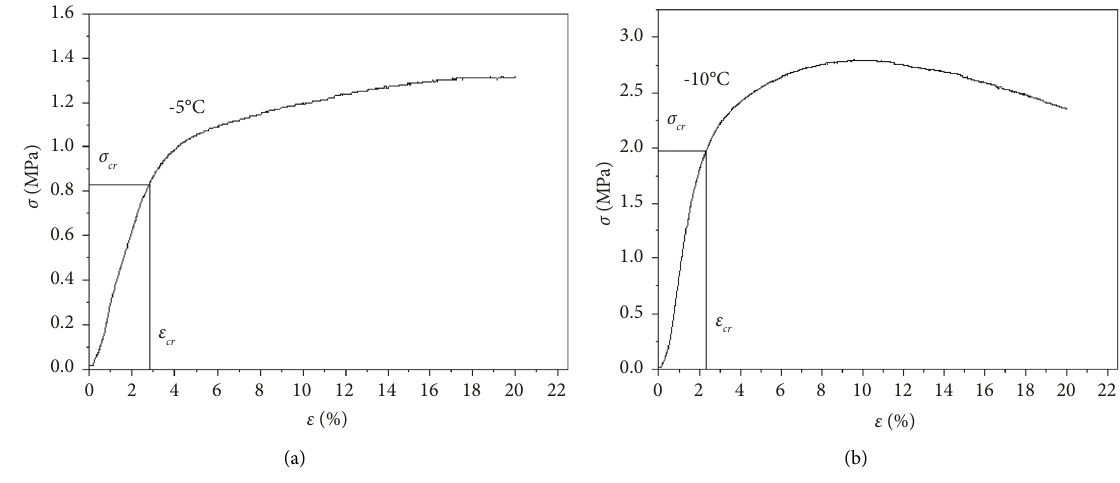
Figure 7: Damage starting point of two stress-strain states. Table 3: The relationship between threshold of strain damage and temperature.